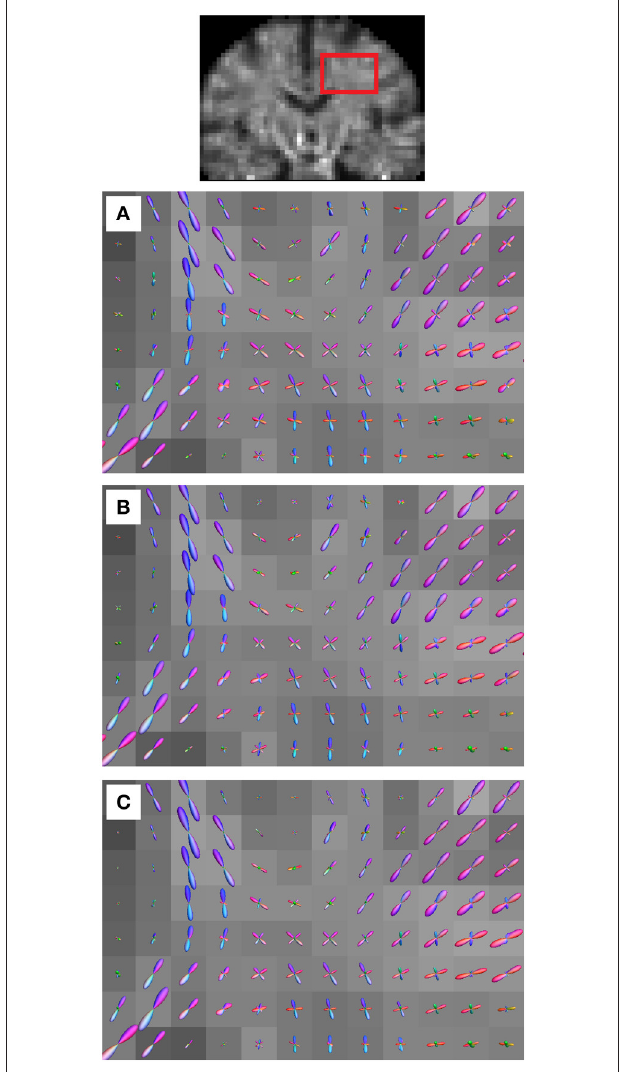
FIGURE 5 | The results of CSD applied to (A) the HARDI converted from the multi-shell data, (B) the HARDI converted from DSI data, and (C) the original HARDI data. The fiber orientation distribution functions (fODFs) show similar patterns and comparable angular resolution.